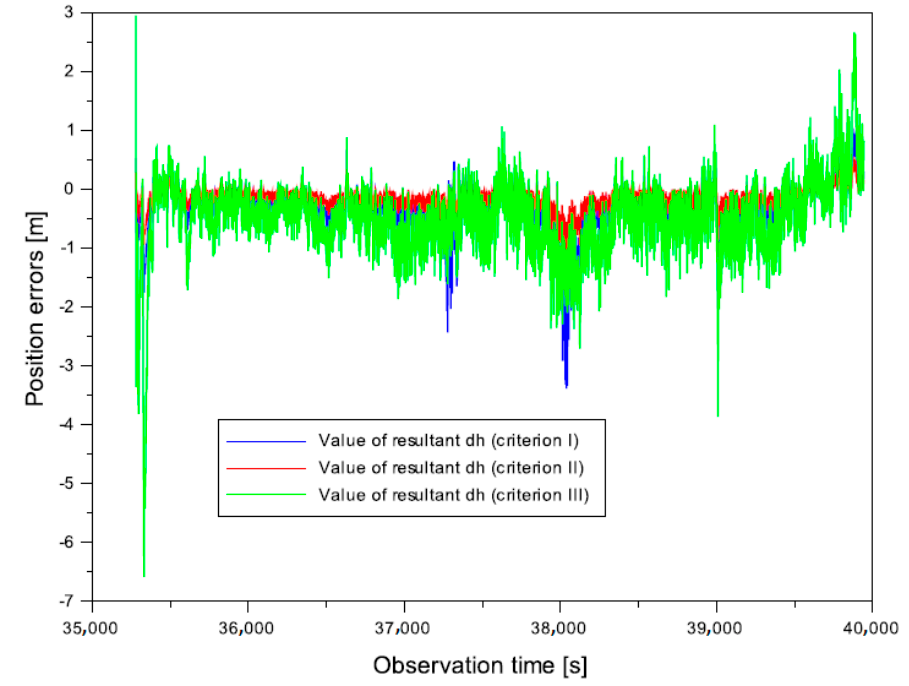
Figure 23. The values of resultant position errors dh .